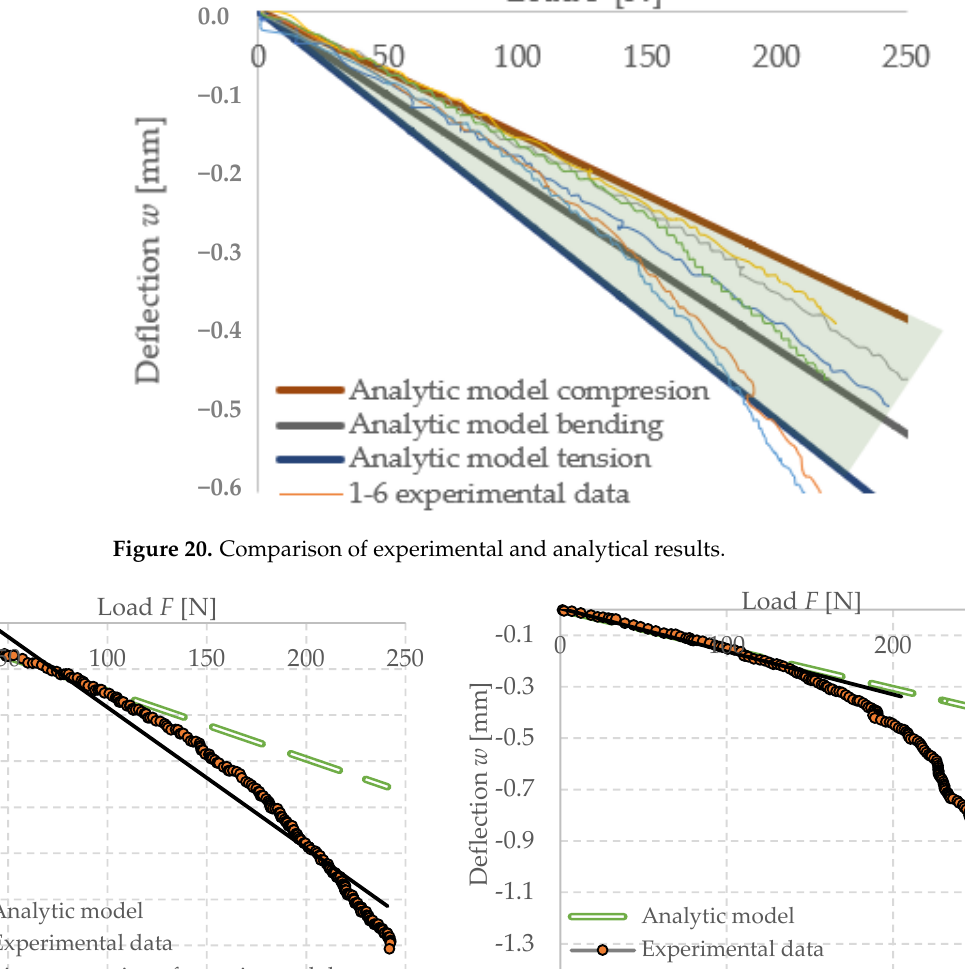
Figure 20. Comparison of experimental and analytical results.